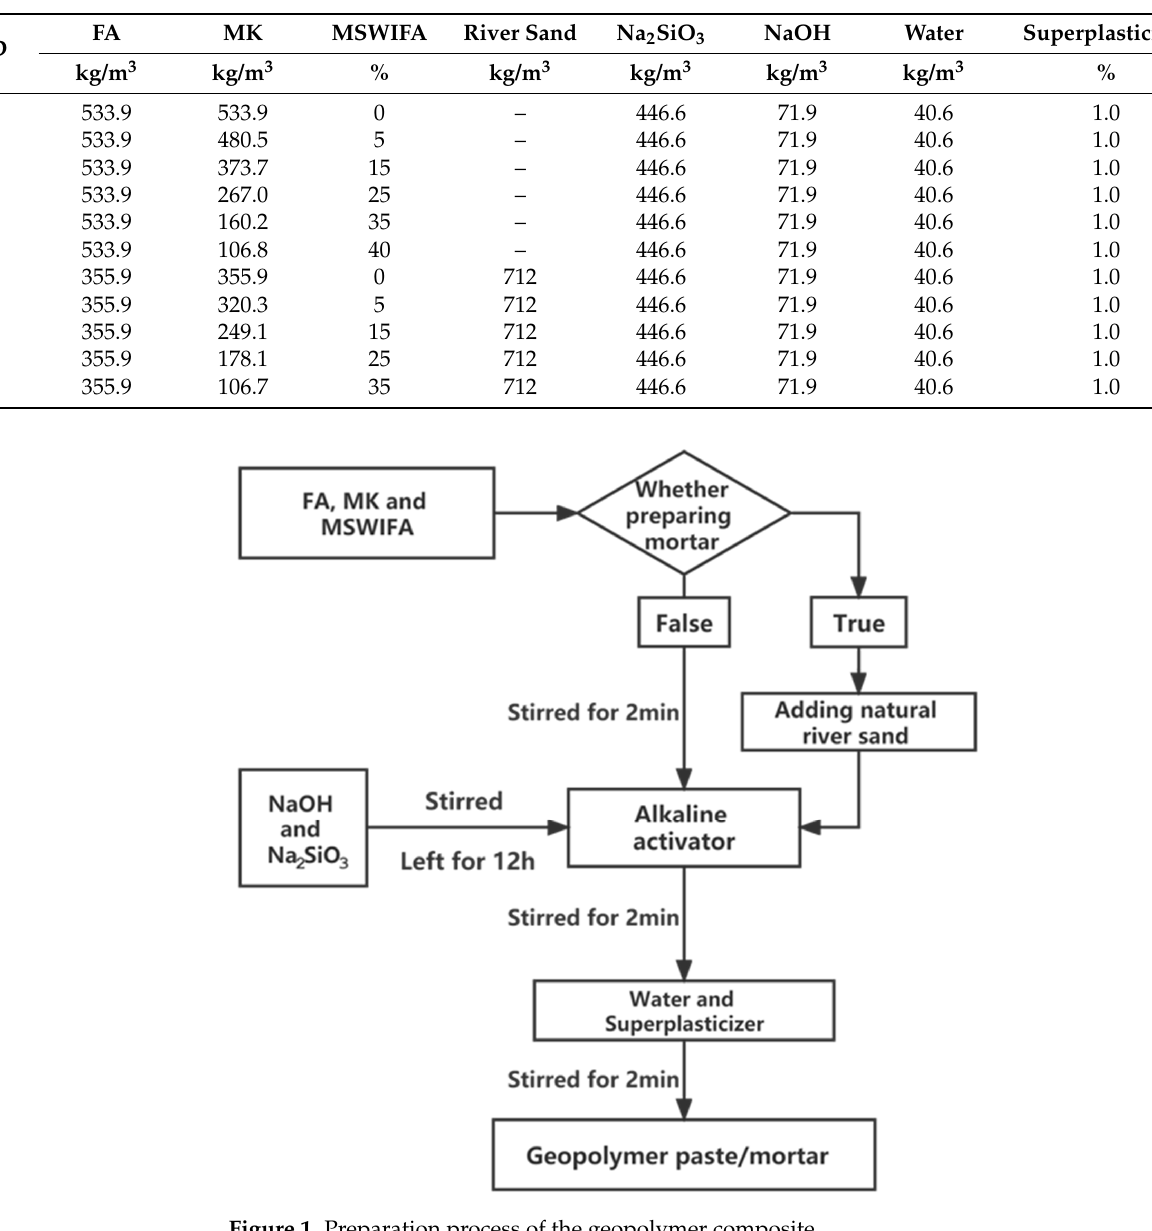
Figure 1. Preparation process of the geopolymer composite.